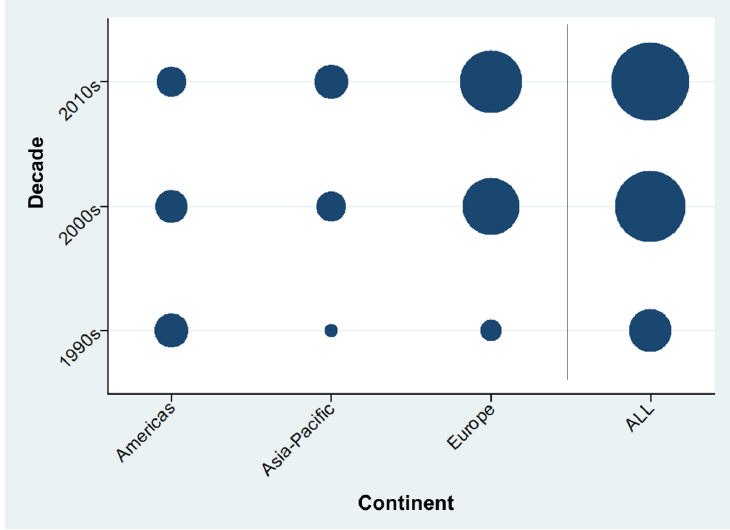
Figure 4. Historic and geographic distribution of the collected sources describing VR applications in design.